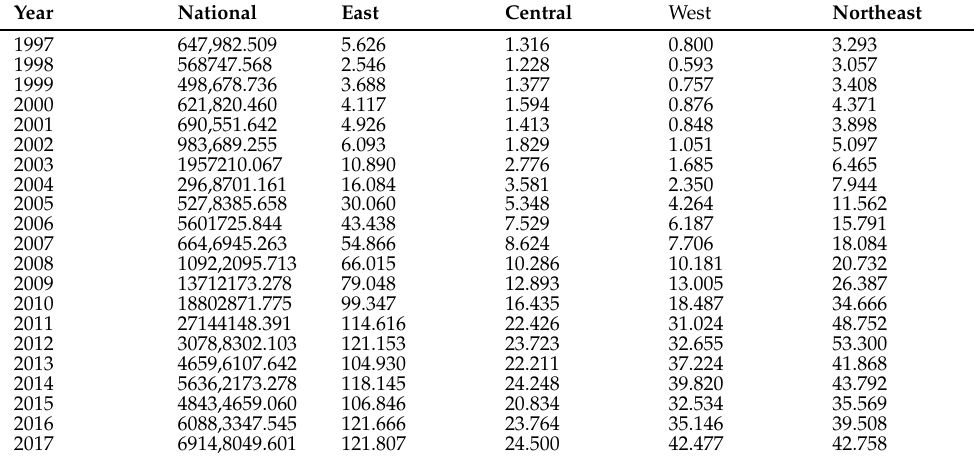
Table 7. The inter-provincial carbon inequality estimation results of original carbon emission data for the nation and the east, central, west and northeast four regions in China from 1997 to 2017. For the division criteria of China’s four regions, please refer to NBSC, see details in